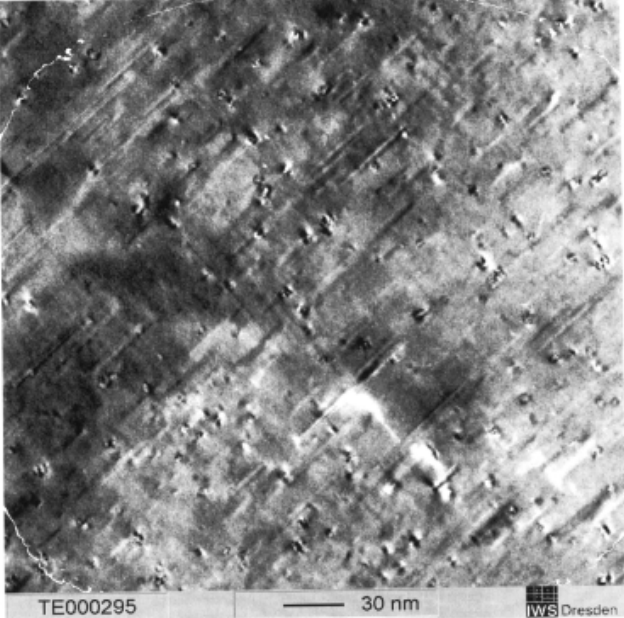
Figure 3. TEM results of the AlMgSi1 alloy as-received (extrusion and cold storage) for two coherent precipitate groups (Guinier–Preston–Zonen), where small particles of precipitate appear in contrast.